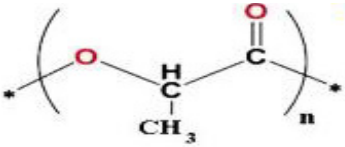
Fig. 5. A) Chemical structure of